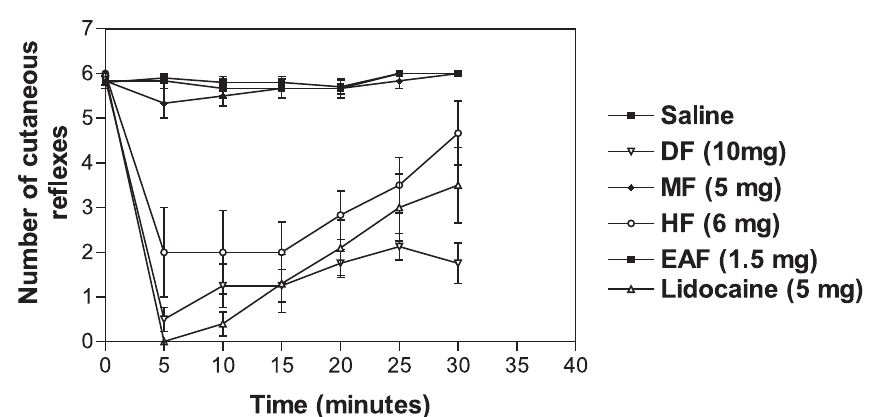
Figure 4 - Effects of Ottonia martiana fractions on cutaneous reflexes in guinea pig wheal test. Animals were treated with fractions (F): MF (methanolic), EAE (ethyl acetate), DF (dichloromethane) and HF (hexane) for 30 min. The control groups were treated with saline (negative) or lidocaine